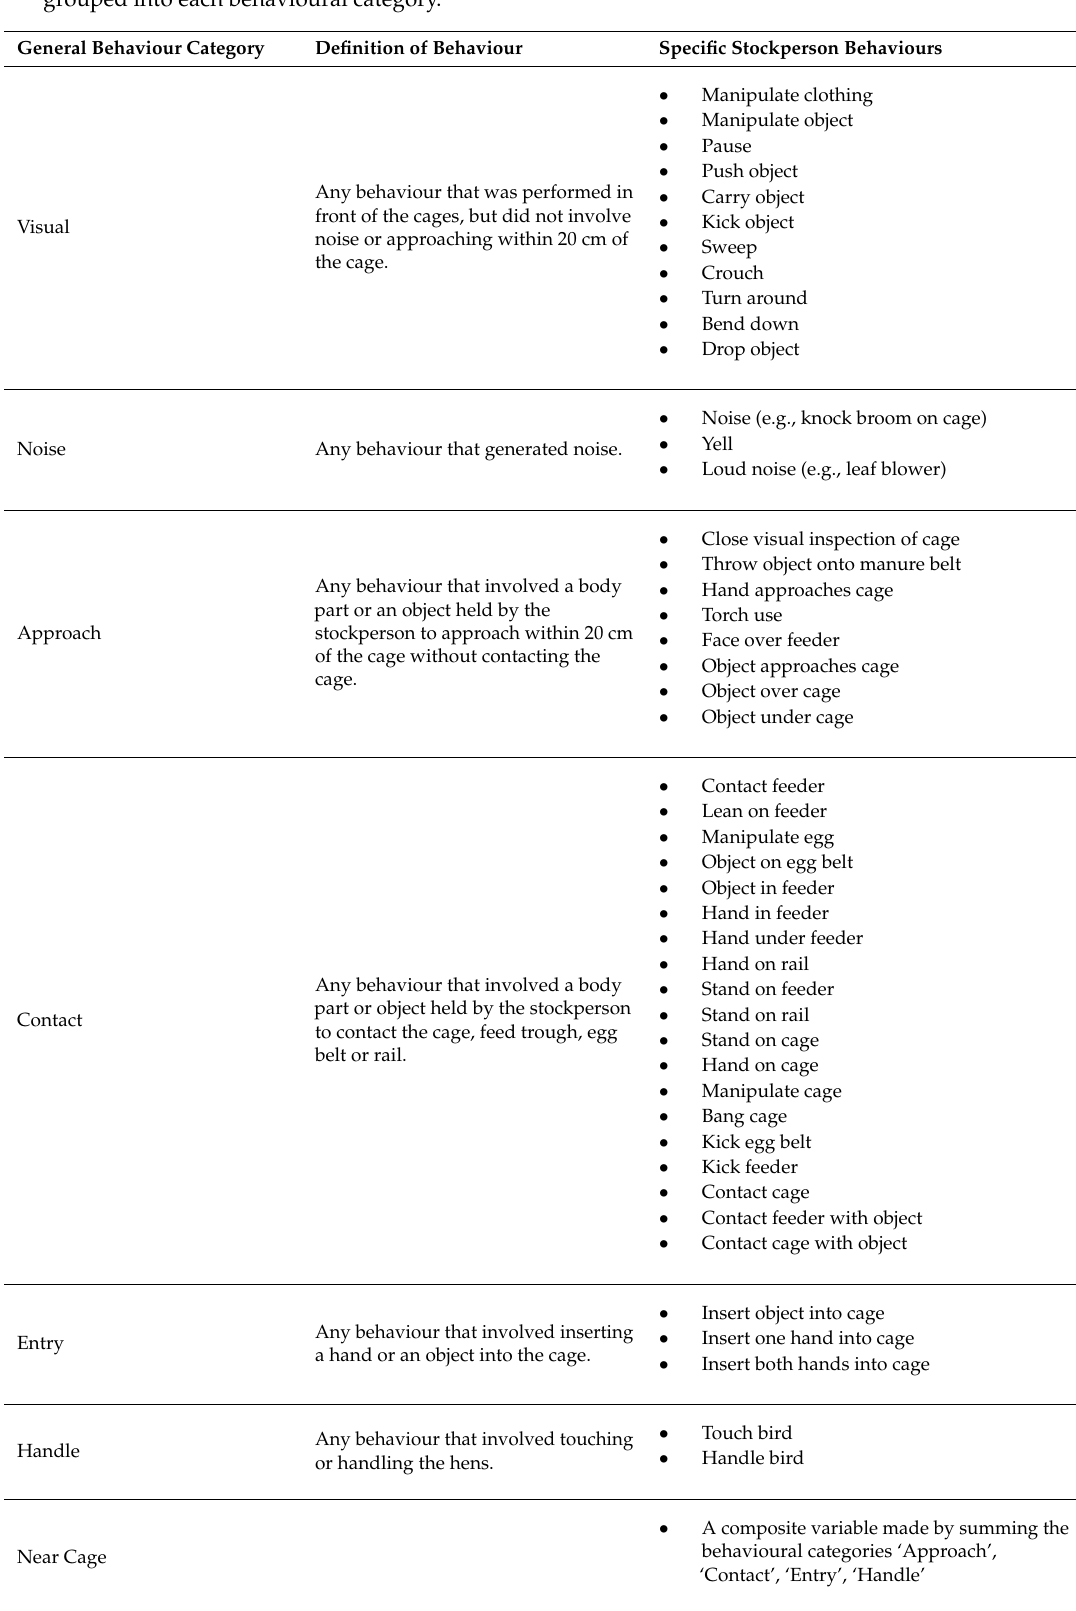
Table 2. An ethogram of the specific stockperson behaviours that were recorded, and how they were grouped into each behavioural